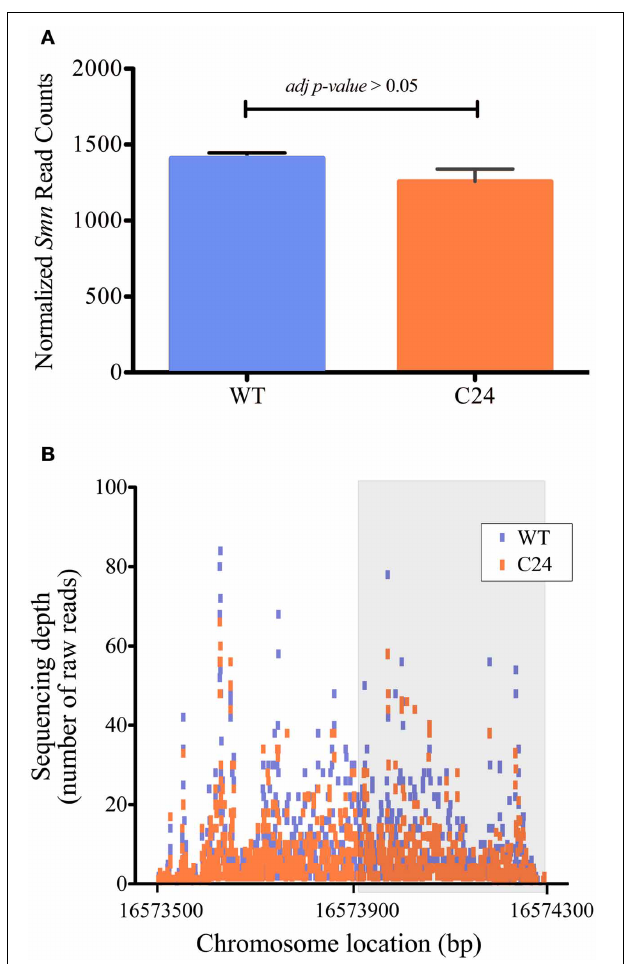
FIGURE 4 | Quantification of the expression levels of the RNAi target Smn in WT and C24 datasets is not affected by detection of reads from the shRNA construct. (A) Normalized read counts of the Smn gene using size factor normalization (see Materials and Methods). Testing for differential expression shows that Smn is not significantly down-regulated in the C24 strain ( adjp − value > 0 . 05). (B) Number of raw sequencing reads aligned along the Smn gene in WT and C24 libraries. Gray box marks the Smn region targeted by the shRNA transcript. No significant difference between the two strains is observed, suggesting that endogenous gene quantification is not biased by the detection of shRNA derived transcripts.